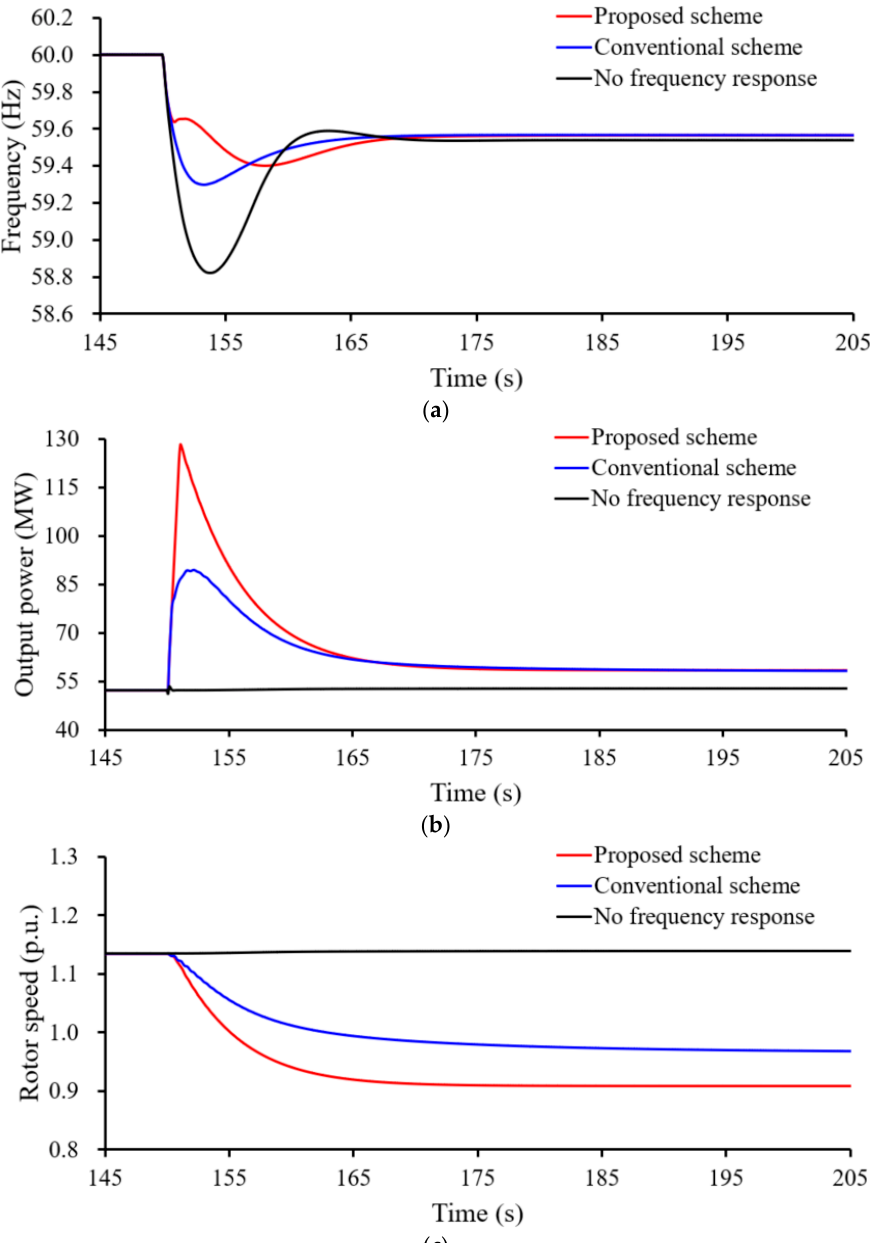
Figure 11. Results for Case 2 : ( a ) Frequency; ( b ) Active power; ( c ) Rotor speed.